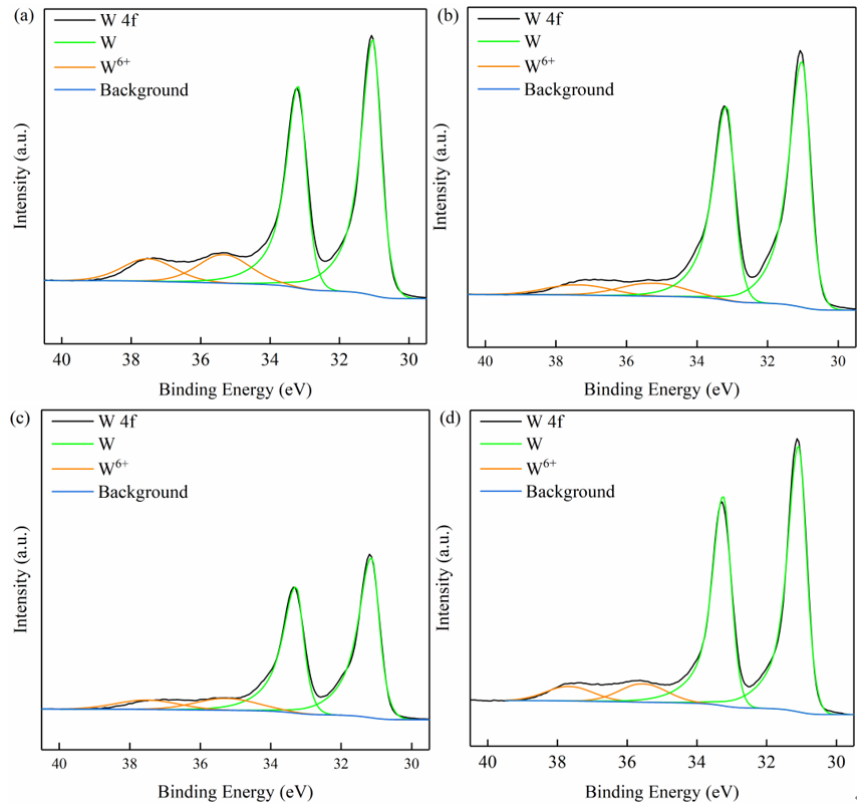
Figure 16. X ‐ ray photoelectron fine spectra of the tungsten surface under different conditions: ( a ) pH 9 solution immersion; ( b ) H 2 O 2 solution immersion; ( c ) polishing slurry solution immersion; ( d ) after C ‐ SDP.